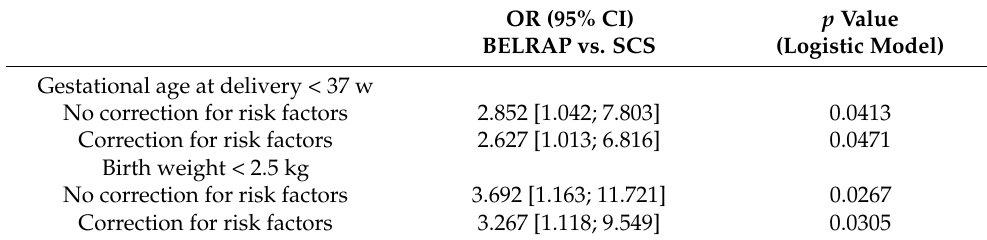
Table 4. Logistic regression models for preterm birth and low birthweightoutcomes compar- ing SCS and BELRAP “IVF-only” singletons after fresh embryo transfer (OR = Odds Ratio, CI = Confidence